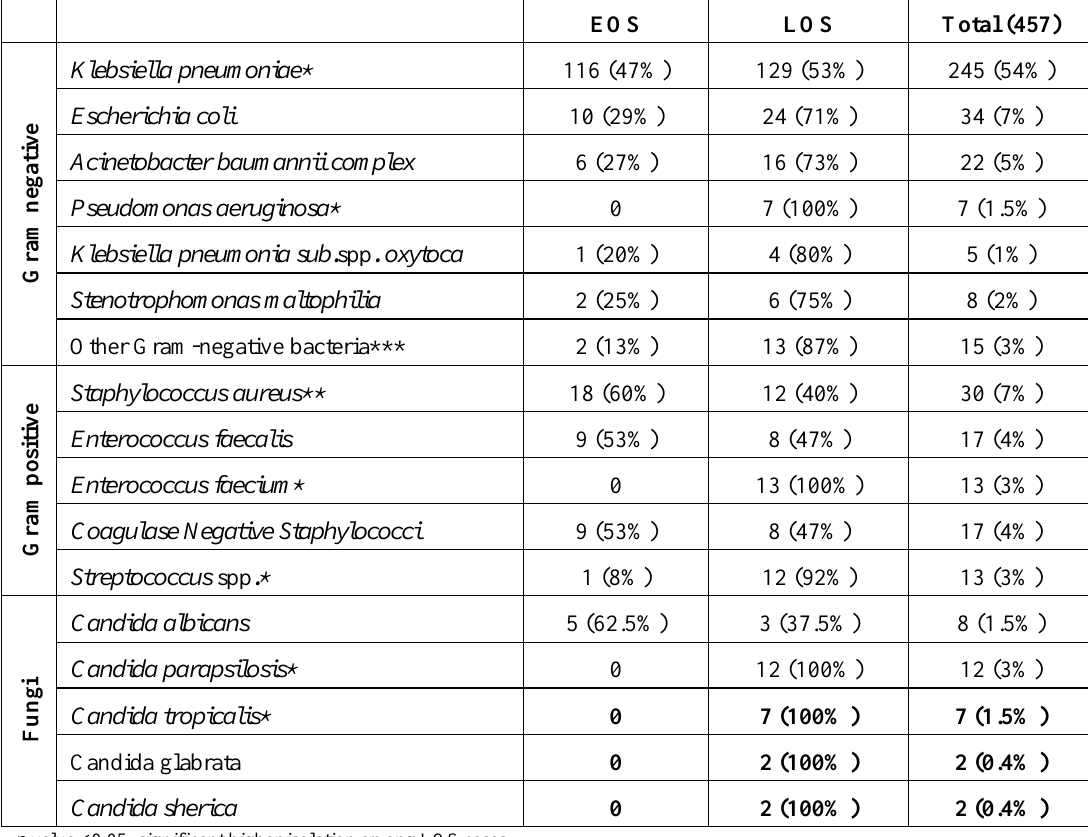
Table 2 . Prevalence of microorganisms isolated from positive blood cultures of neonates with early and late onset